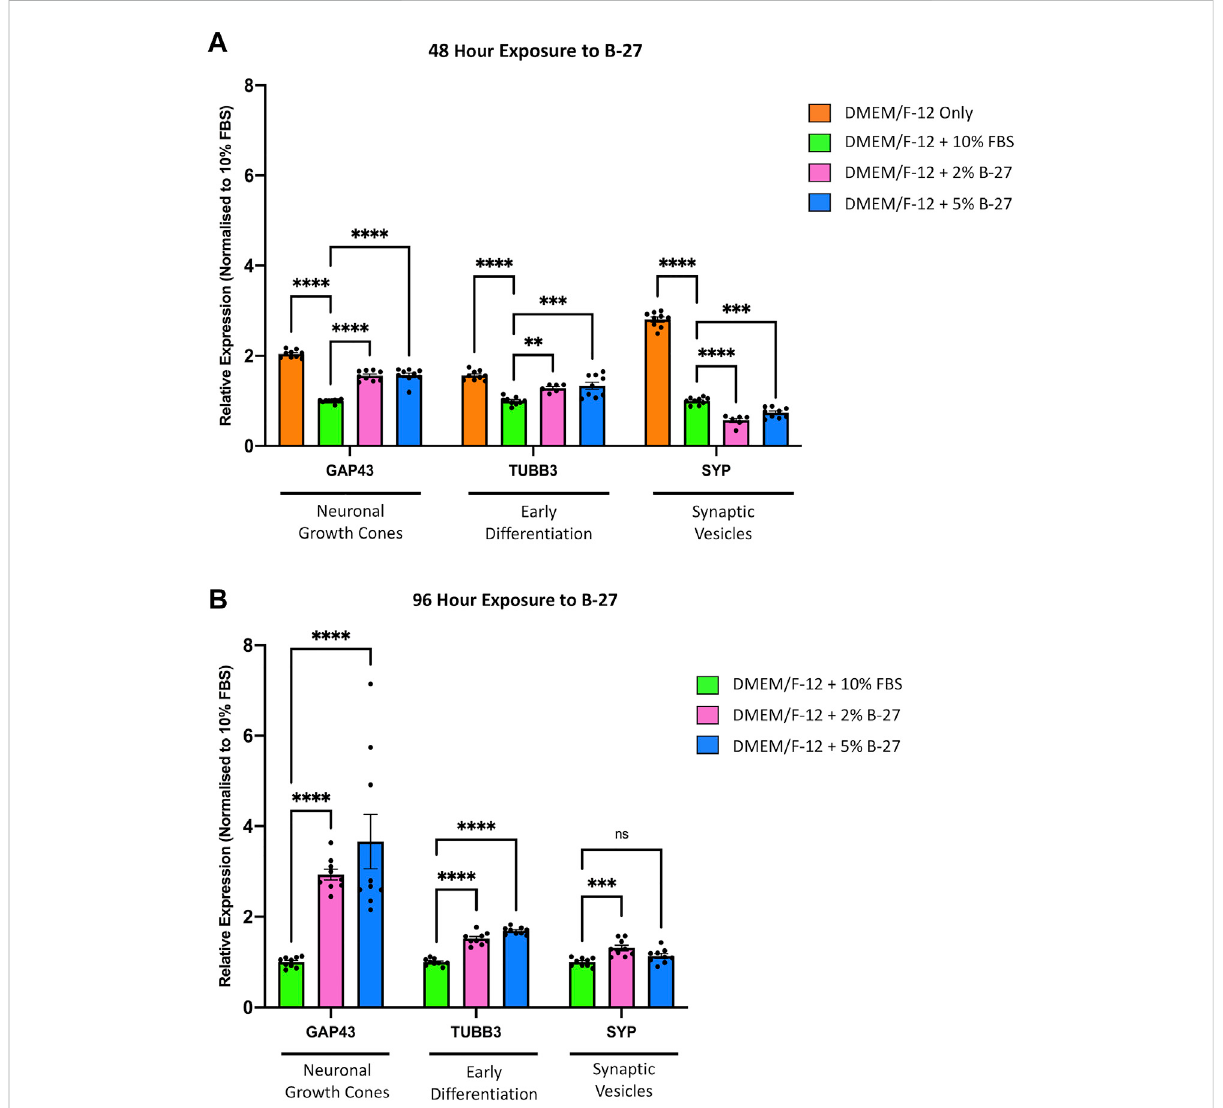
FIGURE 6 B-27 induces SH-SY5Y cell differentiation. SH-SY5Y cells were cultured in DMEM/F-12 only, or DMEM/F-12 supplemented with either 10% FBS, 2% B-27 or 5% B-27 for (A) 48 h or (B) 96 h. qRT-PCR was performed to measure mRNA expression of differentiation markers, GAP43 , TUBB3 and SYP . Relative expression of GAP43 , TUBB3 , and SYP (standardized to GAPDH and POLR2A ) normalized to the DMEM/F-12 + 10% FBS culture conditions. Data presented as mean ± SEM. N = 3 independent biological samples with two to three technical replicates each. Statistical signi fi cance against the DMEM/F-12 + 10% FBS condition was determined using ordinary one-way ANOVA and Tukey ’ s multiple comparison tests in GraphPadPrism version 9.0.0 for Mac, GraphPadSoftware,San Diego, California,United States, www.graphpad.com. ns = not signi fi cant; * p <